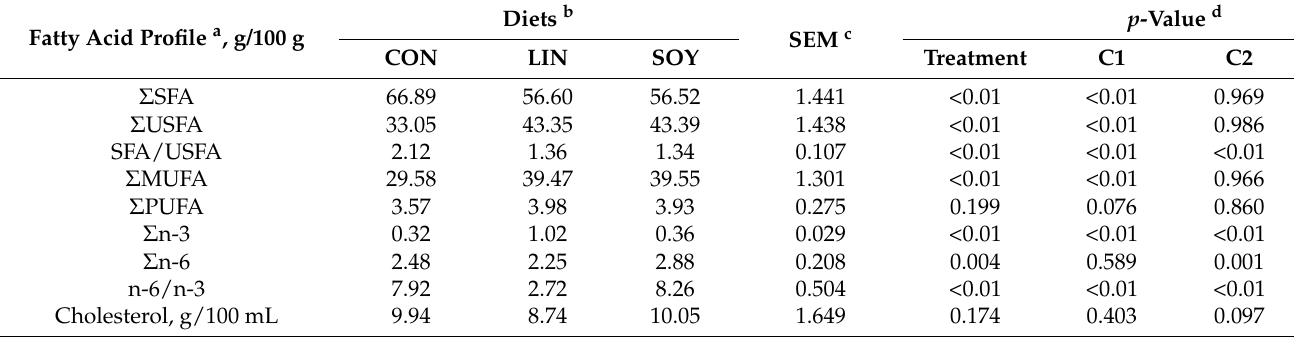
Table 1. The lipid fraction of milk from Holstein dairy cows fed diets supplemented linseed and soybean oil. p -Value d Diets b Fatty Acid Profile a , g/100 g SEM c CON LIN SOY Treatment C1 C2 Σ SFA 66.89 56.60 56.52 <0.01